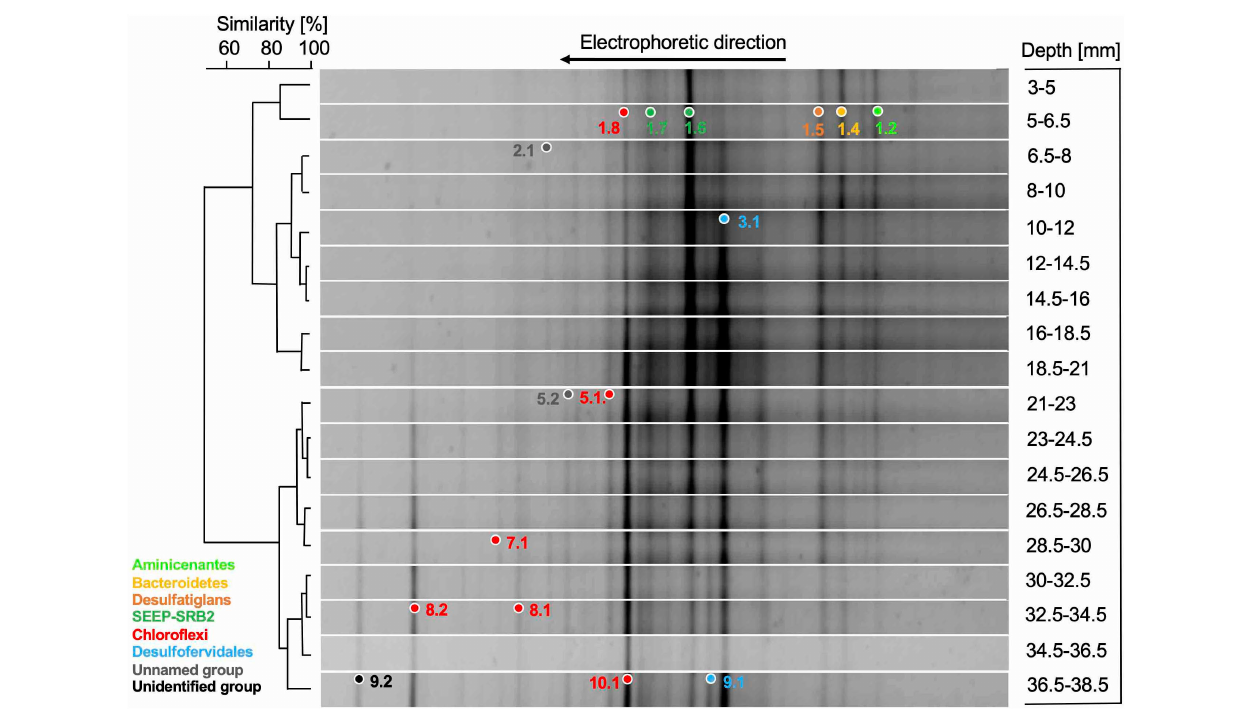
FIGURE 2 | DGGE analysis of bacterial 16S rRNA genes from sediment core 4868-7, with similarity clustering pattern and positions of excised and sequenced DGGE bands, color-coded to match their phylogeny. The DGGE lanes of the deepest PCR-positive sediment samples, 38–40 and 40–42 mm, showed the same pattern as the 36–38 mm layer, but the bands were faint and the DGGE lanes are not shown.